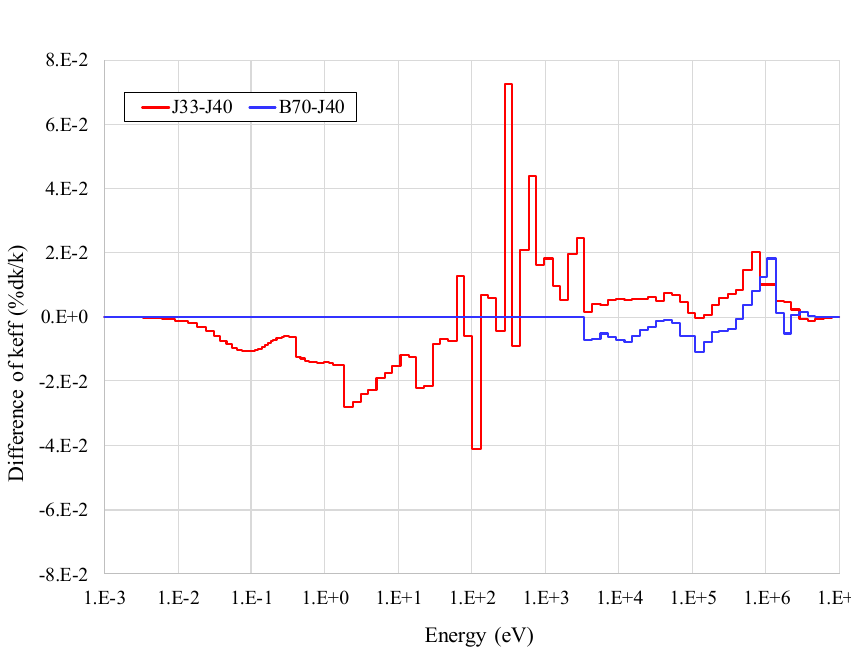
Figure 6. Energy - wise contributions of k